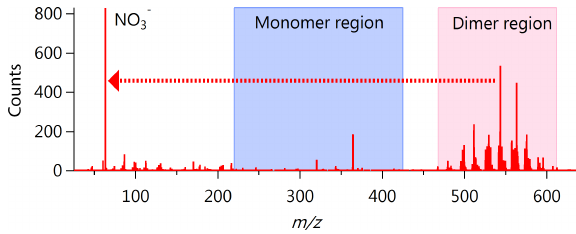
Figure 10. A 20V CID-MS of laboratory α -pinene ozonolysis prod- ucts averaged over the drift time region of the HOMs dimers (52– 55ms) in the 2-D IMS–MS plot. Note that these data were ac- quired under different operating conditions than those in Fig. 6, leading to slightly different IMS drift times. The appearance of NO − -signal in the CID-MS results from fragmentation of the weak 3 bond between NO − -and the α -pinene HOMs dimer. The absence of 3 monomer fragments in the CID-MS at this same voltage suggests that the monomer units within the dimers are bonded to each other more strongly (likely via covalent bonding). The large peak in the monomer region is a perfluoroheptanoic acid calibrant ( m/z